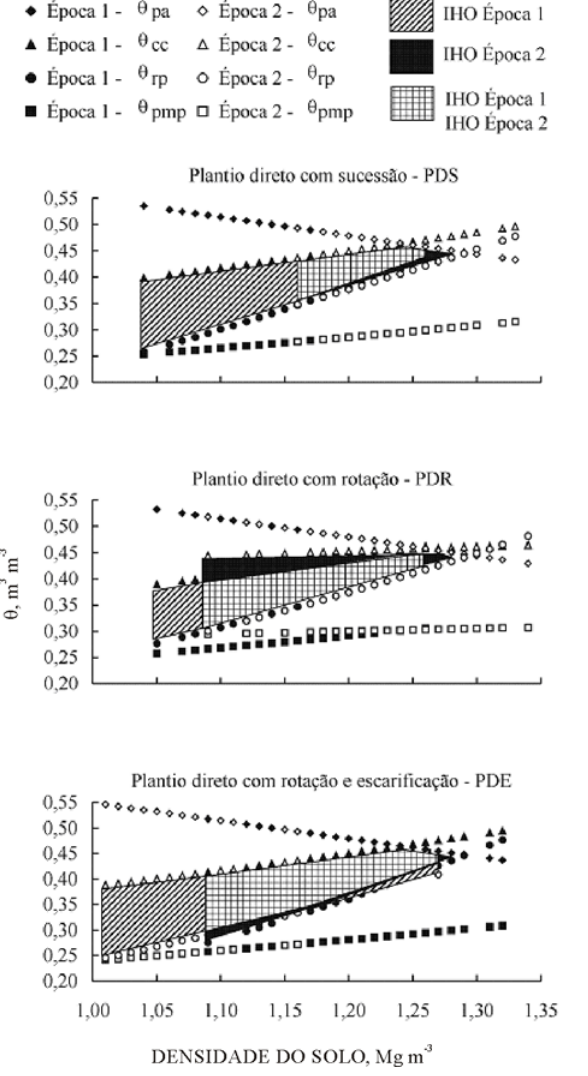
Figura 1. Variação do conteúdo de água ( θθθθθ ) com a densidade do solo para os três tratamentos, nos níveis críticos de capacidade de campo ( θθθθθ ponto de murcha permanente ( θθθθθ de aeração de 0,10 m 3 m -3 ( θθ θθθ solo à penetração de 3,5 MPa ( θθθθθ hachuradas correspondem ao intervalo hídrico ótimo (IHO) nas épocas de